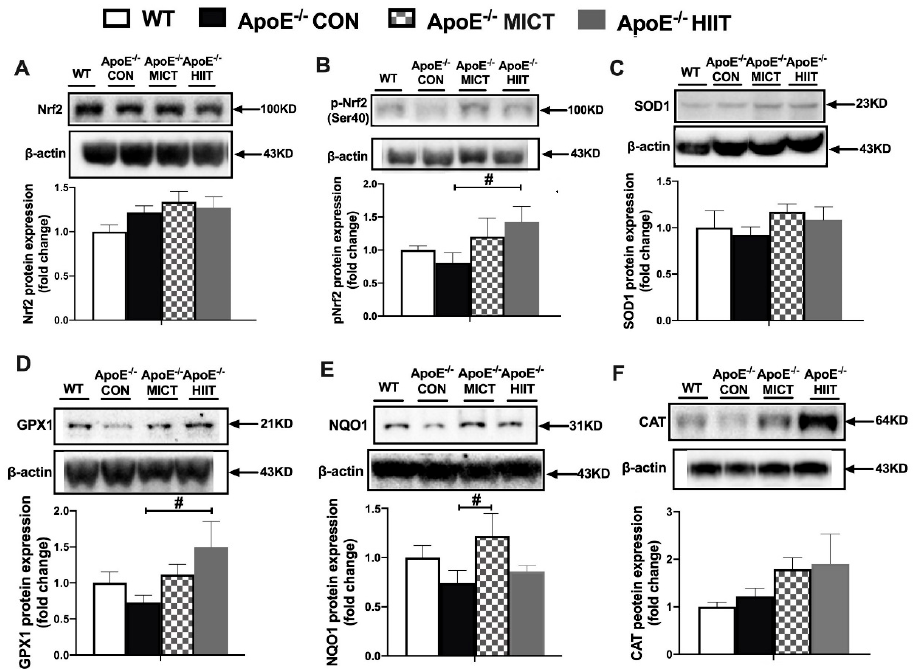
Figure 5. Effects of HIIT and MICT on the protein expression of Nrf2 ( A ), p-Nrf2 (ser40) ( B ), and antioxidants ( C – F ) in skeletal muscles of WT and ApoE KO mice with HFD. Values are displayed as the mean ± SEM (n = 10/group). # p < 0.05 vs. ApoE -/- CON.